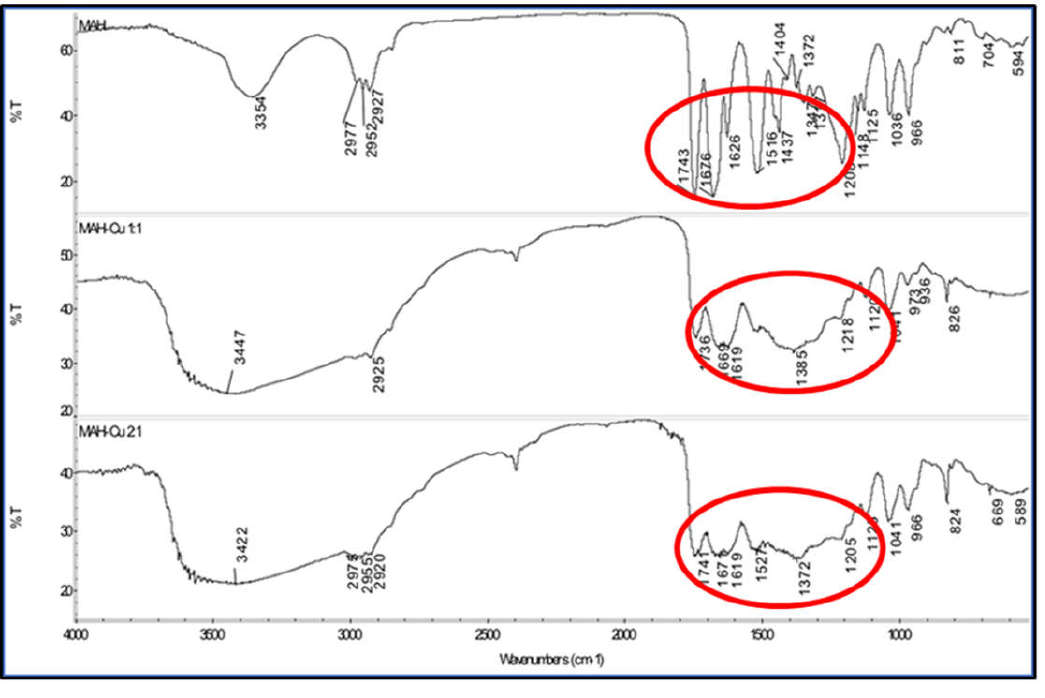
Figure 2. FTIR spectra of MAH monomer (upper), MAH-Cu(II) (middle), and 2MAH-Cu(II) (bot- tom) complexes. Fingerprint area: red